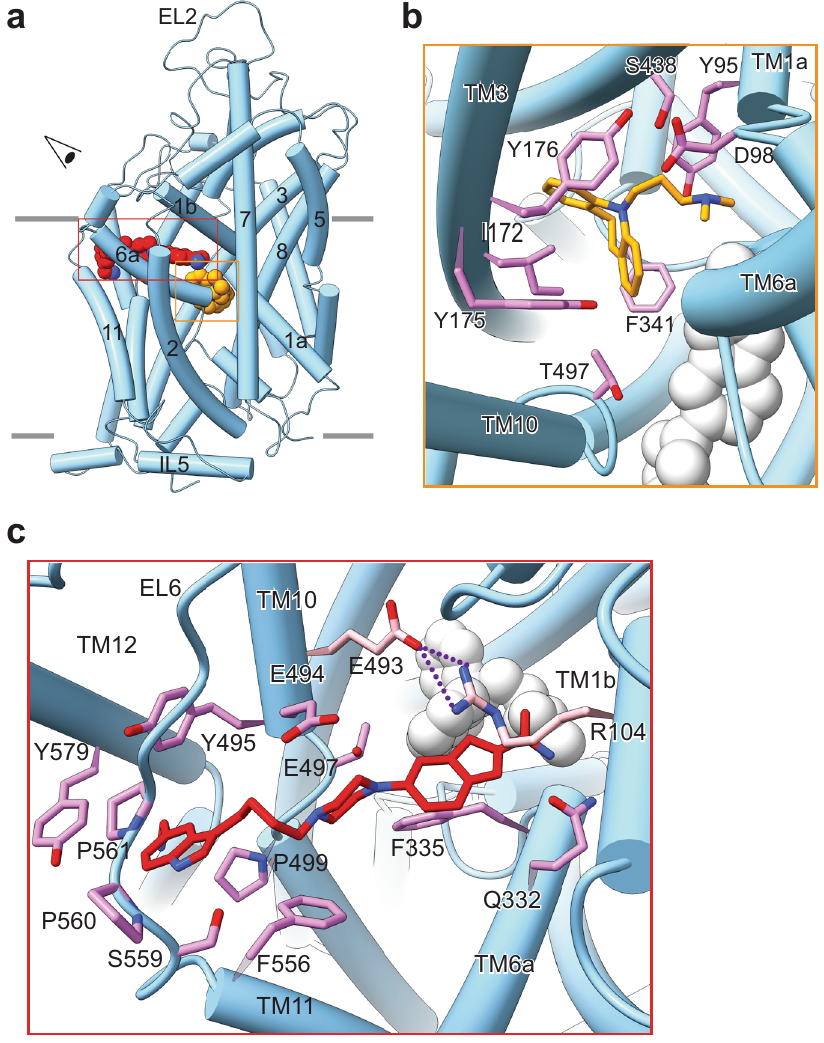
Fig. 4 Detailed representation of the binding sites for IMI and VLZ in SERT. a Overall view of SERT:IMI:VLZ complex in cartoon representation; IMI (yellow) and VLZ (red) are depicted as spheres. The “ eye ” represents the angle view depicted in ( b ) and ( c ). b Detailed representation of the IMI binding site in S1. IMI binding is mainly formed by side chain residues in TM1, 3, 6, 8, and 10. Residues that interact with IMI are annotated and shown in violet sticks. IMI is shown in yellow sticks and VLZ as gray sphere. c Detailed representation of the VLZ binding site in S2. Residues that interact with VLZ are annotated and shown in violet sticks, Arg104 and Glu493 are shown in pink. VLZ is shown in red sticks and IMI as gray sphere. The salt bridge formed between Arg104 and Glu493 is shown as purple dashed lines. TM: Transmembrane, EL: Extracellular loop, IL: